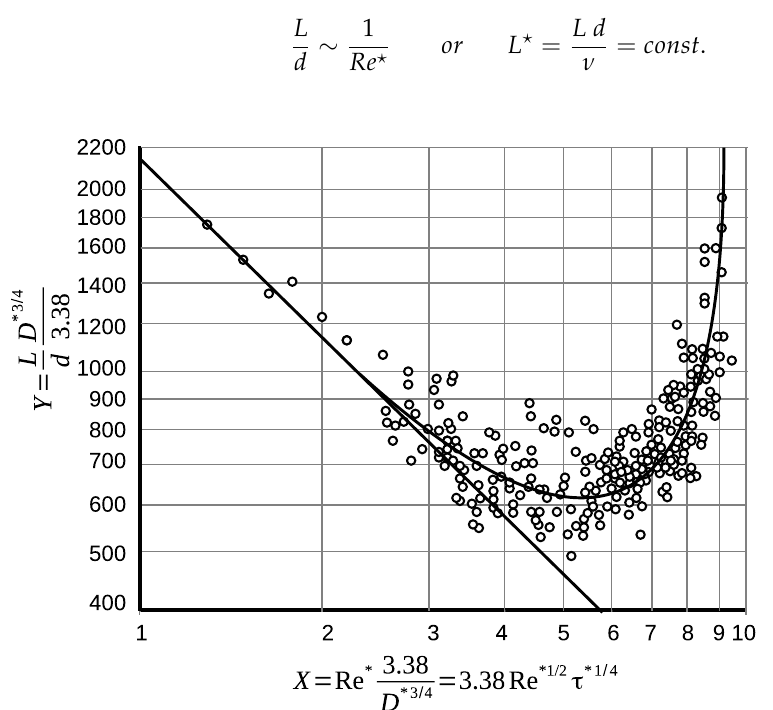
Figure 3. Prediction for ripple lengths according to Yalin [16] based on measurement results of different